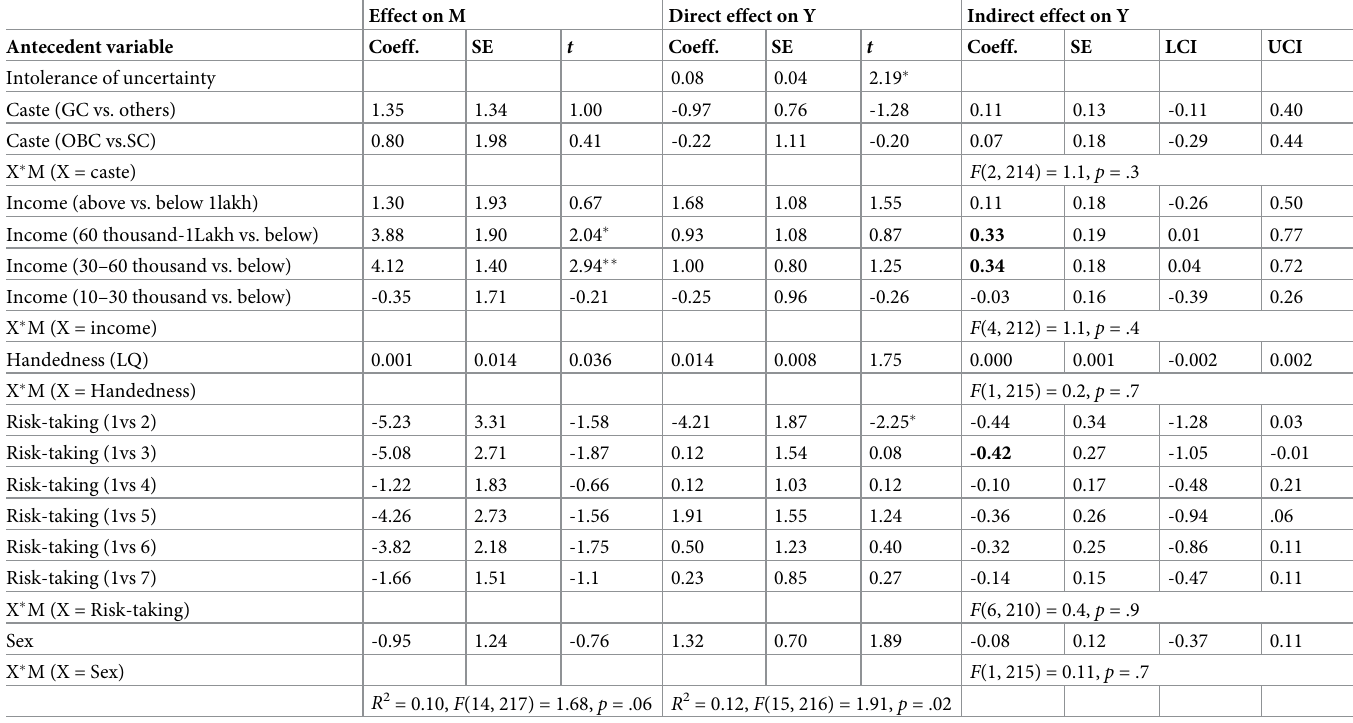
Table 14. The effects (direct and indirect effect) of antecedent and mediation (general IU) variables on bonding in the community